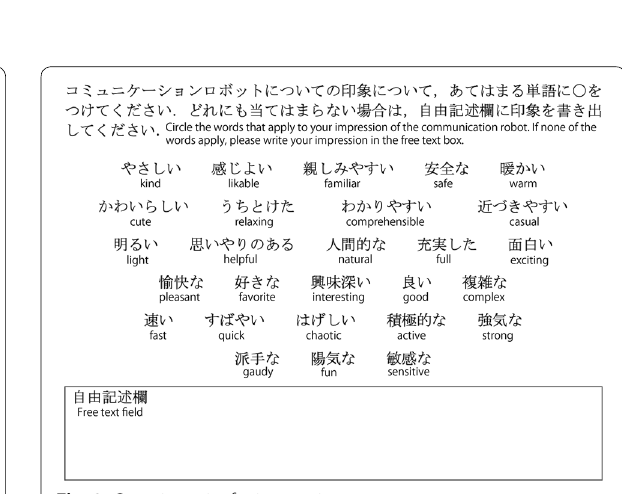
Fig. 3 Questionnaire for impression